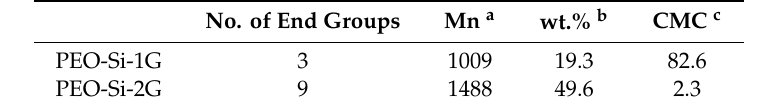
Table 1. Physicochemical properties of LDBS.